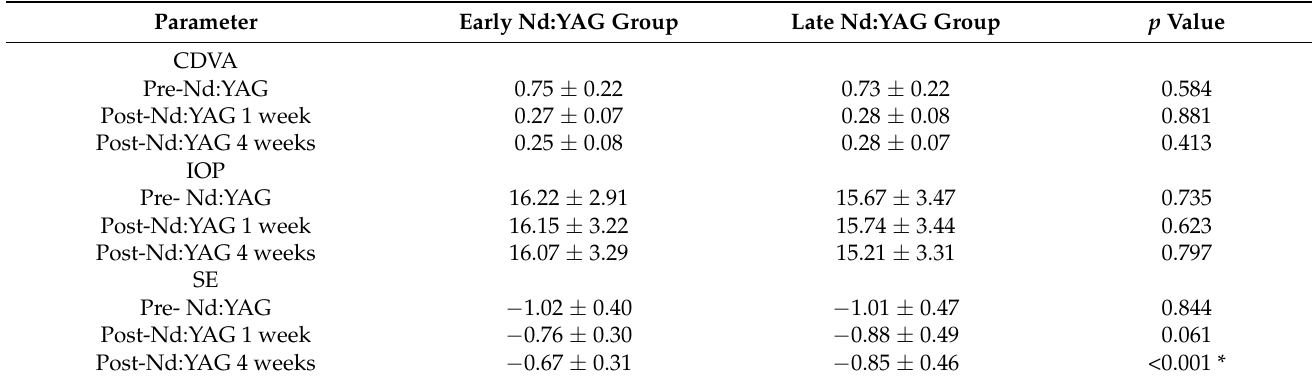
Table 4. The comparison of vision, intraocular pressure, and refraction between the two groups at different time points.